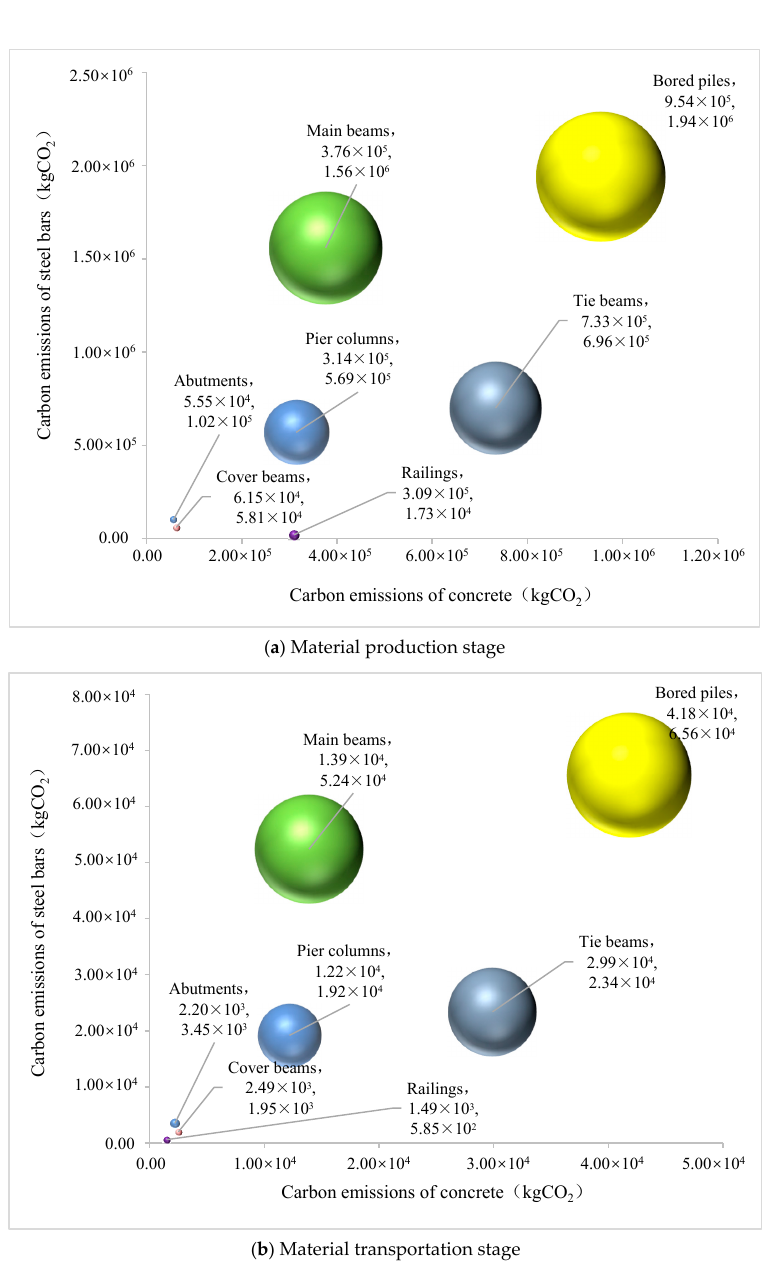
Figure 6. Comparison of carbon emissions of different components.